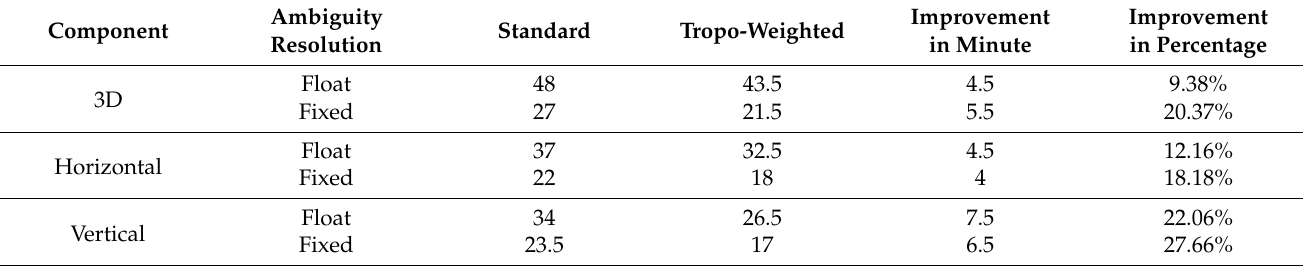
Table 4. Summary of the convergence times to achieve 10 cm positioning accuracy of the standard and tropospheric-weighted model with 90% probability in kinematic positioning mode (the unit is